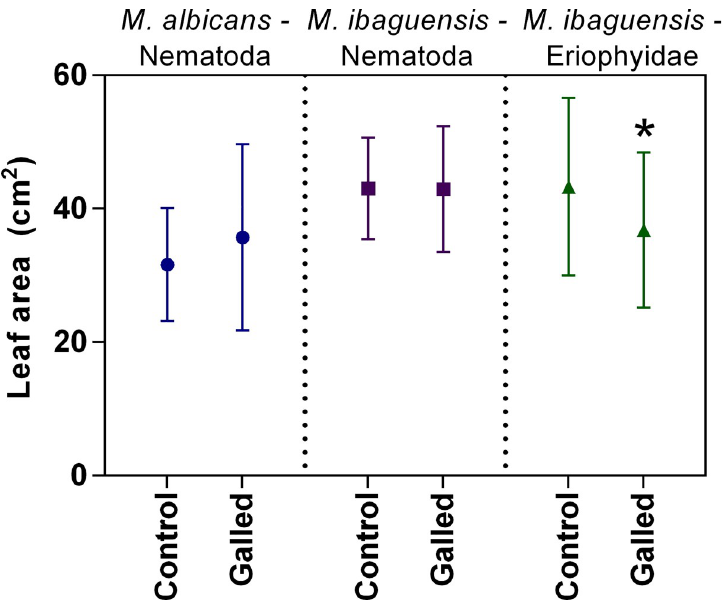
Fig 2. Areas (cm 2 ) of control leaves and leaves galled by Ditylenchus gallaeformans (Nematoda) on Miconia albicans ; by D . gallaeformans on M . ibaguensis ; and by an unidentified Eriophyidae on M . ibaguensis . The bars indicate the means and standard deviations. The asterisk indicates significant difference ( P <